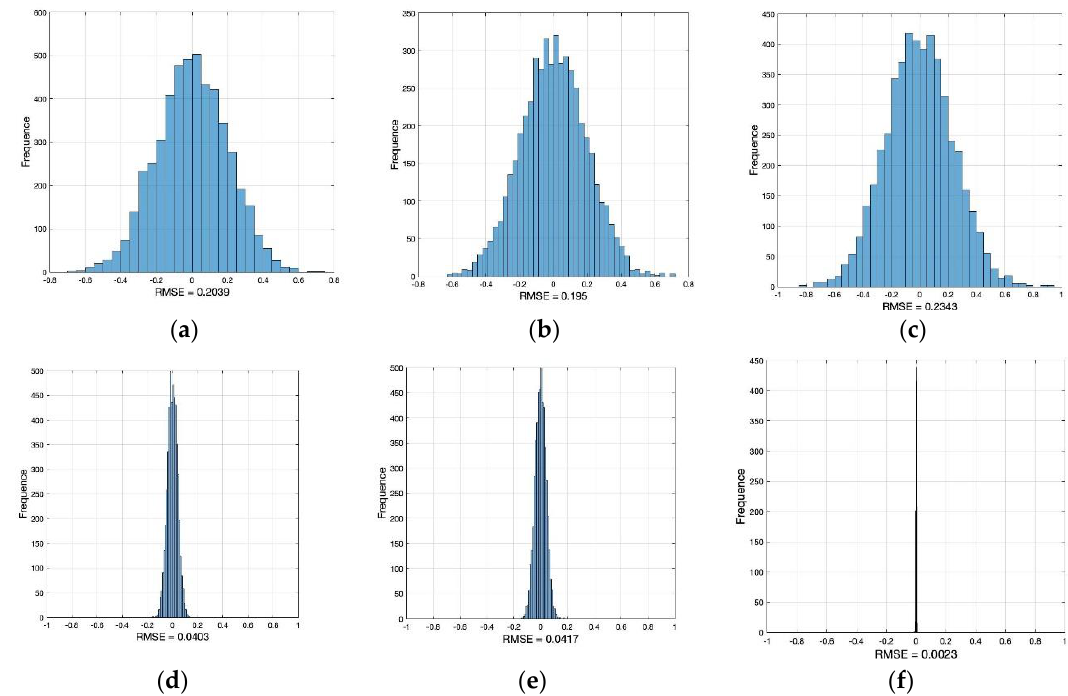
Figure 9. Calculation of model error. ( a ) The RMSE of Z4. ( b ) The RMSE of Z5. ( c ) The RMSE of Z6. ( d ) The RMSE of Z7. ( e ) The RMSE of Z8. ( f ) The RMSE of Z9.